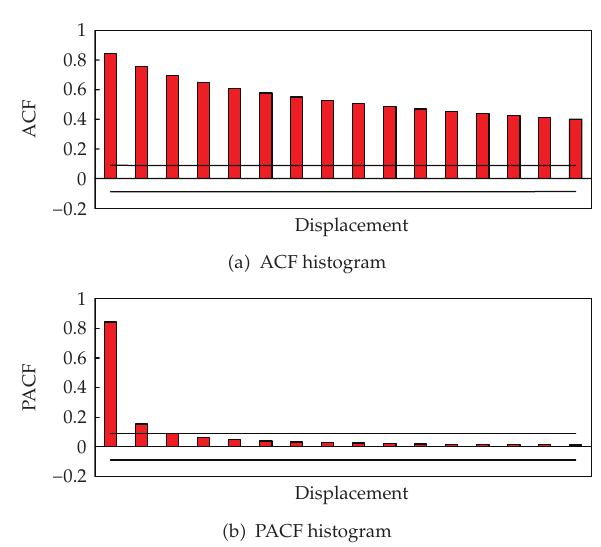
Figure 7: Histograms of spatial ACF and PACF based on the power-law distribution.